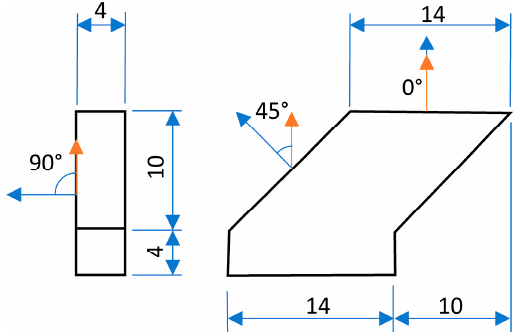
Figure 4. Specimen shape and dimensions.